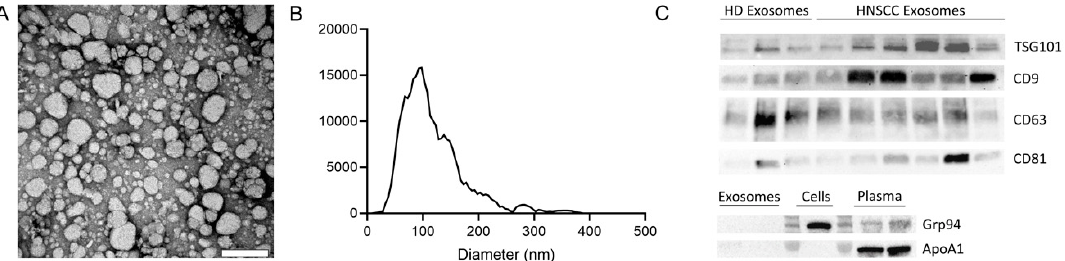
Figure 1. Characterization of exosomes isolated from plasma. ( A ) Representative transmission electron microscopy (TEM) image of exosomes. Scalebar = 200 nm. ( B ) Representative size distribution of exosomes measured by nanoparticle tracking analysis (NTA). ( C ) Exosomes derived from plasma of healthy donors (HD) and head and neck squamous cell carcinoma (HNSCC) patients were analyzed by Western blot for the presence of exosome specific markers using antibodies against CD63 and CD81 under non-reducing conditions and antibodies against CD9 and TSG101 under reducing conditions. Western blot analysis for the negative marker Grp94 and the apolipoprotein Apo1A was also performed for exosomes, cells, and plasma.